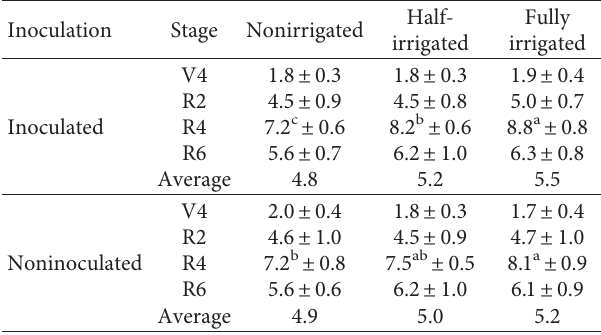
Table 7: The effect of different irrigation regimes on LAI at dif- ferent stages of soybean’s (cv. Bogl´ar) life cycle, averaged among 2017, 2018, and 2019 in Debrecen, Hungary.